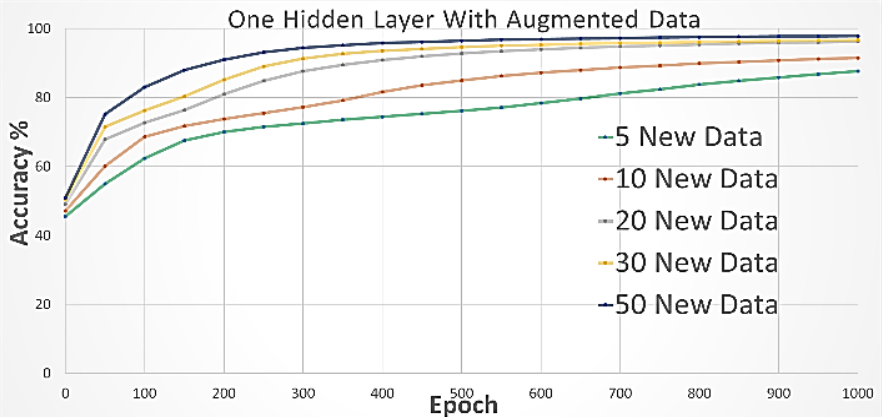
Figure 5. Training with a hidden layer increasing the